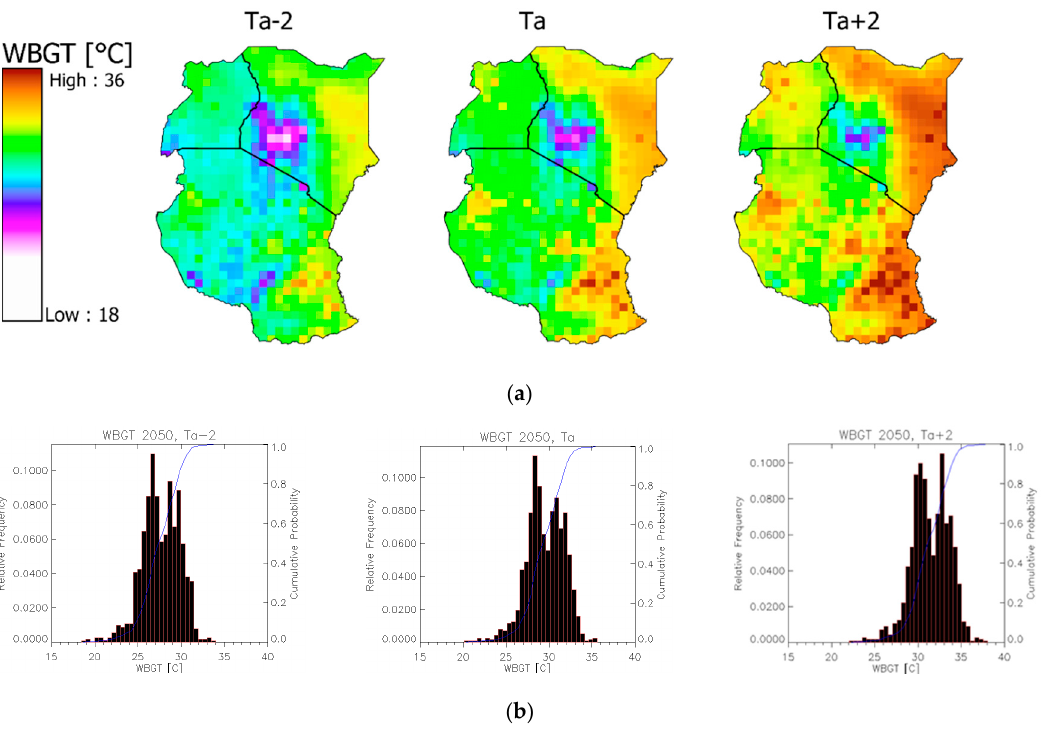
Figure C3. Maximum WBGT for February-March in 2050 assuming a data uncertainty of the surface air temperature of ±2 °C. Spatial distribution ( a ) and histograms with cumulative distributions in blue of maximal WBGT ( b ).